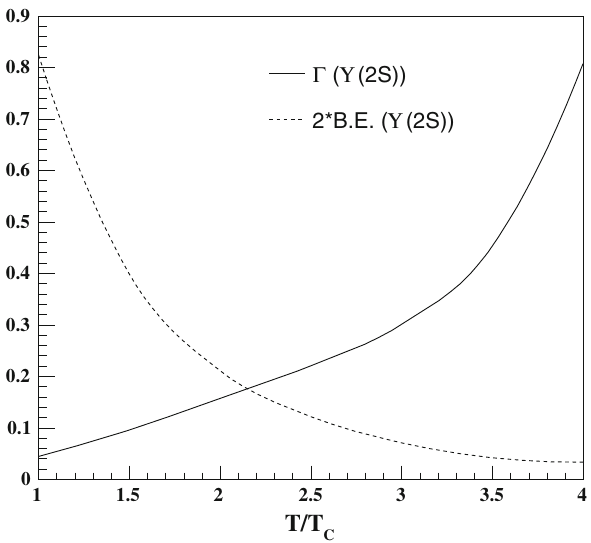
Fig. 19 Variation of two times of binding energy of ϒ( 2 S ) and decay width with respect to T / T C Table 1 Dissociation temperature ( T d ) for various quarkonium states Charmonium states